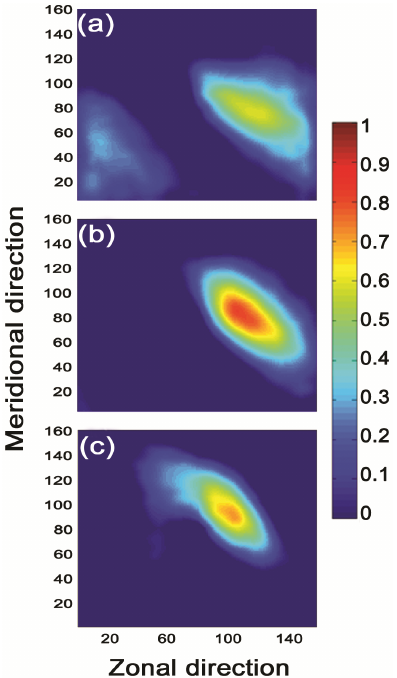
Figure 6. Images showing the output of 2-D cross-correlation between the sequential images (a) 21:44–21:48IST (b) 21:48– 21:52IST and (c) 21:52–21:56IST.